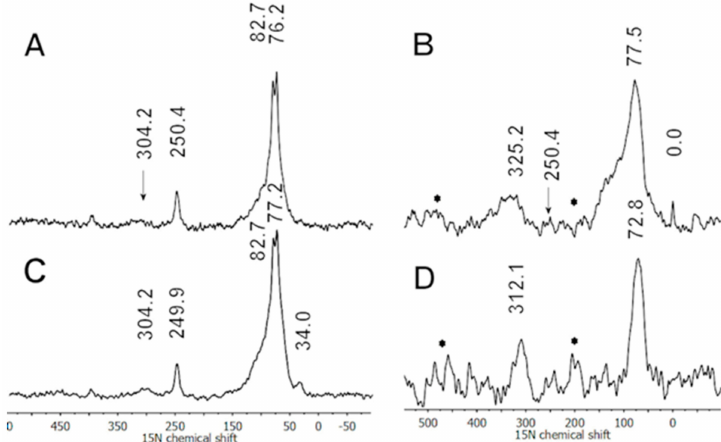
Figure 6. The solid-state 15 N CP / MAS ( A , C ) and direct polarization ( B , D ) NMR spectra of the SD and DD sample, respectively, obtained after 24 h reaction time using ammonium persulfate without a dopant acid. Reprinted with permission from reference [17]. Copyright (2013)